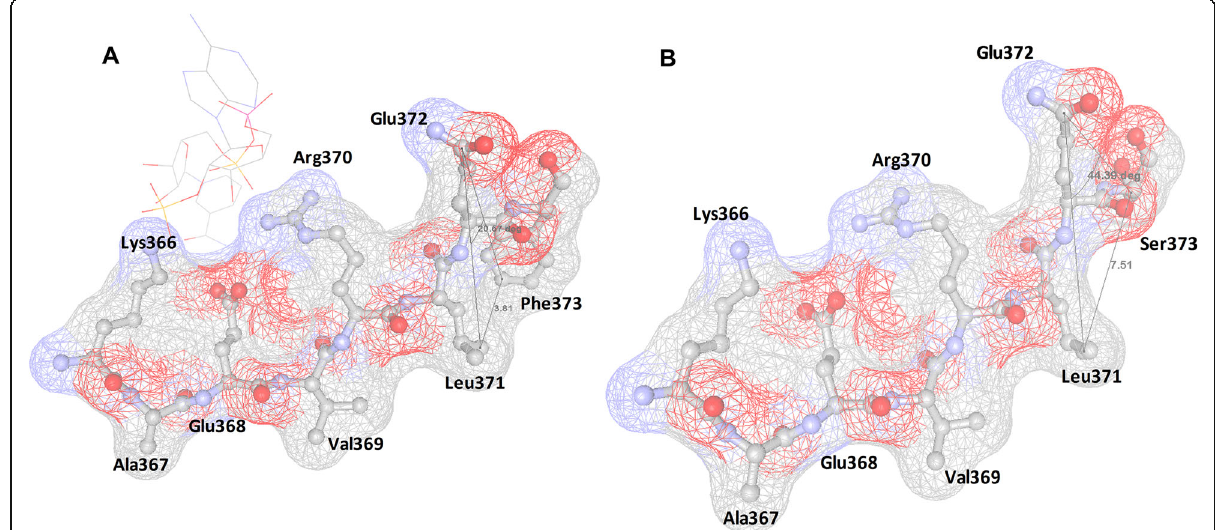
Fig. 5 Modeling of the Phe373Ser mutant (F373S) in the protein G6PD (PDB code 2BH9). The figure was obtained using the software VMD. a The distance from Phe373 to Leu371 of 3.81 Å and the angle of 20.67 °C in the wildtype of Phe373 is shown. b The distance from Ser373 to Leu371 of 7.51 Å, and the angle of 44.39 °C in the variant of Phe373Ser is